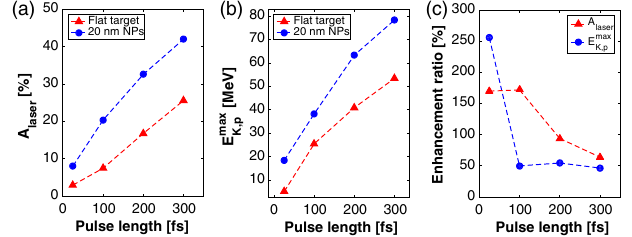
FIG. 2. Pulse length effect on total laser energy absorption A from the target (a) and on the maximum kinetic energy gained by max (b). The enhancement ratio for both parameters is protons E K;p also shown in